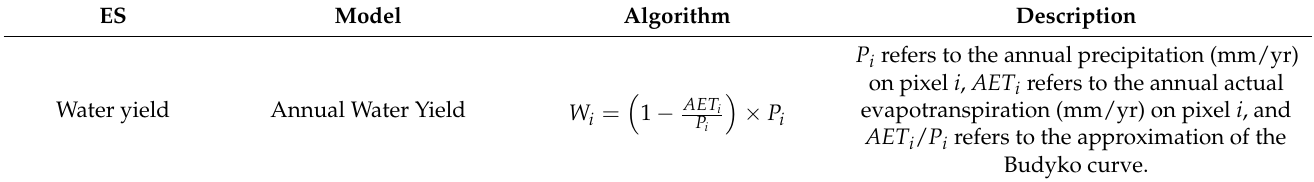
Table 2. Quantifying methods of InVEST models.